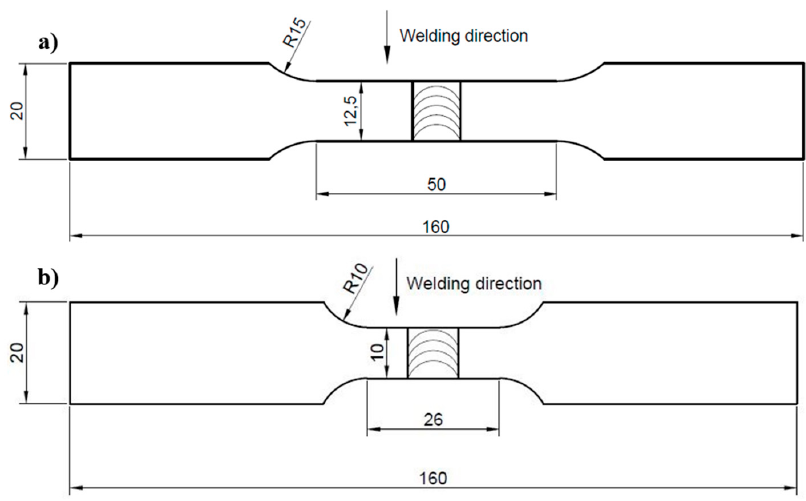
Figure 1. The scheme of sample for ( a ) tensile test and ( b ) low cycle fatigue testing.